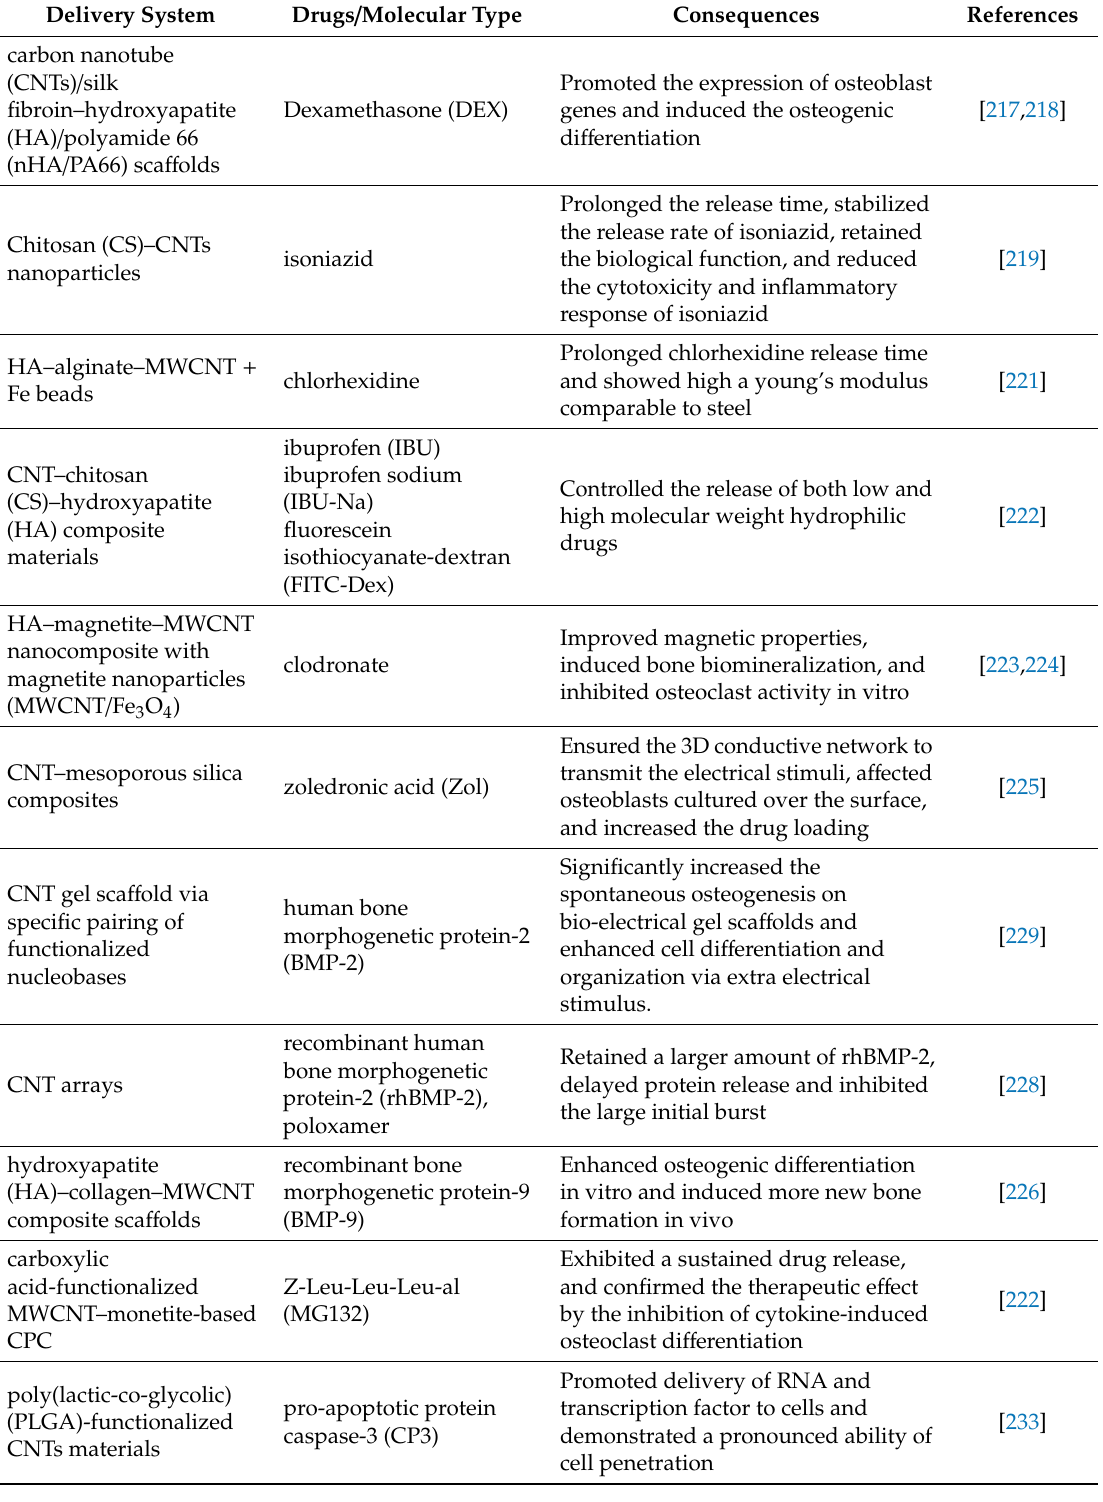
Table 2. Applications of CNT composites as nanocarriers for bone tissue regeneration and